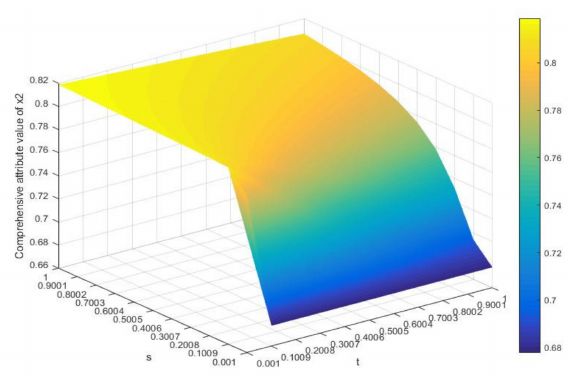
Figure 4. Comprehensive attribute values of x 2 obtained by the TPGWHM ( t , s ∈ [ 0.001,1 ] ).